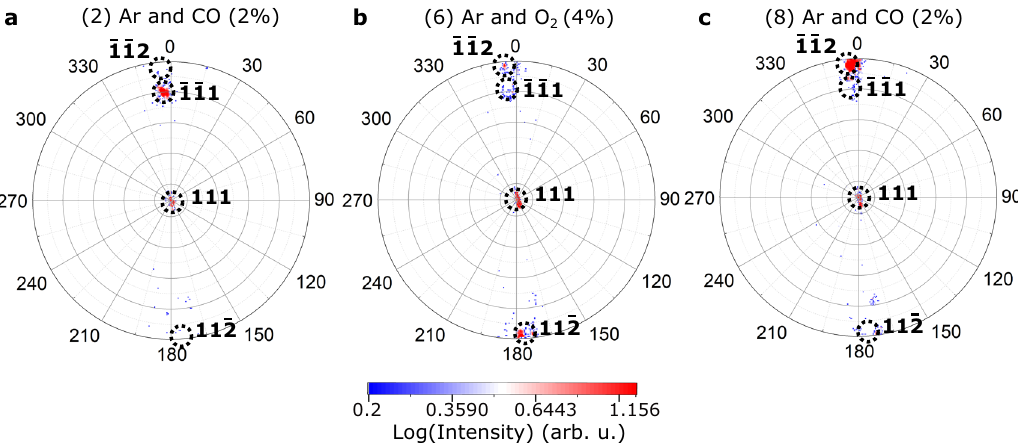
Fig. 3 Faceting evolution. Stereographic projections (pole fi gures) extracted from the 3D diffraction patterns at a Q value of 0.75 nm − 1 from the central 111 Bragg peak and integrated over Δ Q = 0.005 nm − 1 and measured for different gas compositions at 450 °C: a for Ar + CO (2%), i.e. , condition (2) b for O 2 (4% in Ar), i.e. , condition (6) and c for CO (2% in Ar), i.e ., condition (8). Only the intense streaks of the diffraction patterns are observed. The dashed circles indicate the location of the peaks. They are guide for the eye.